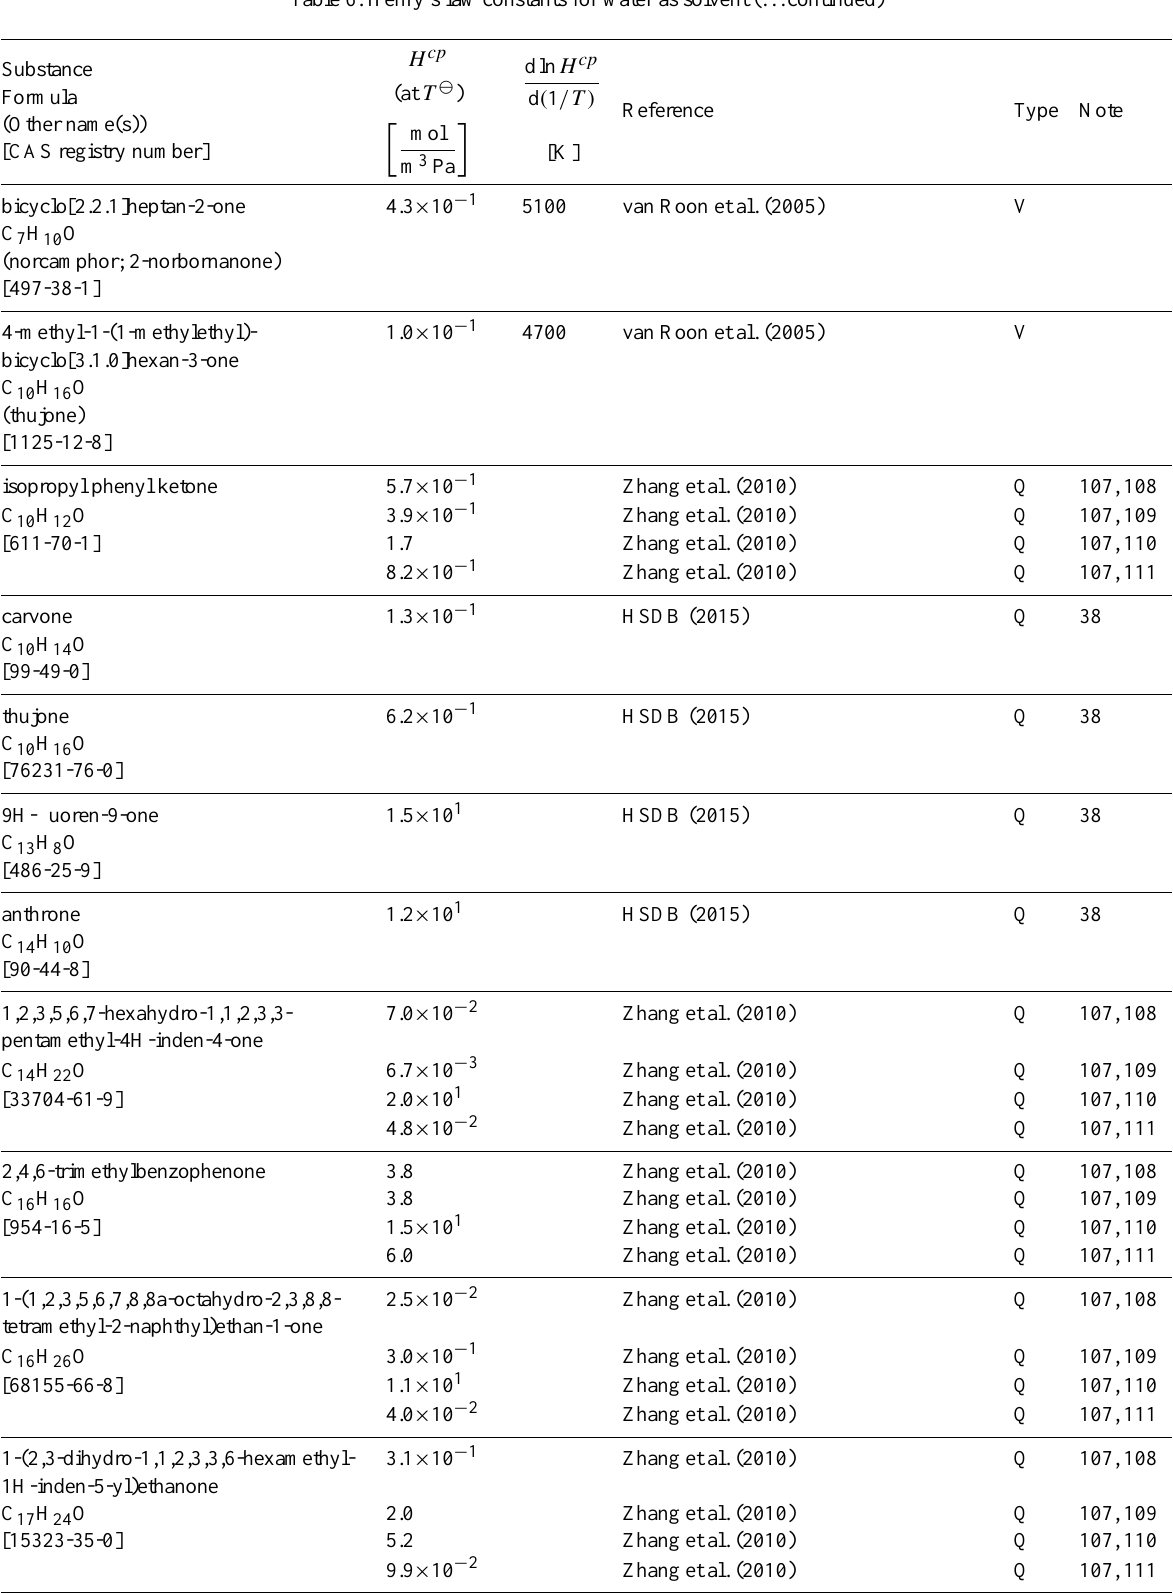
Table 6: Henry’s law constants for water as solvent